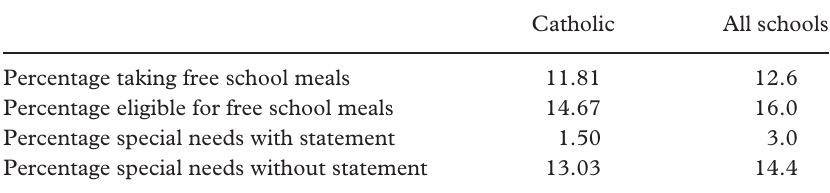
Table 1. Percentage of pupils in maintained schools in England